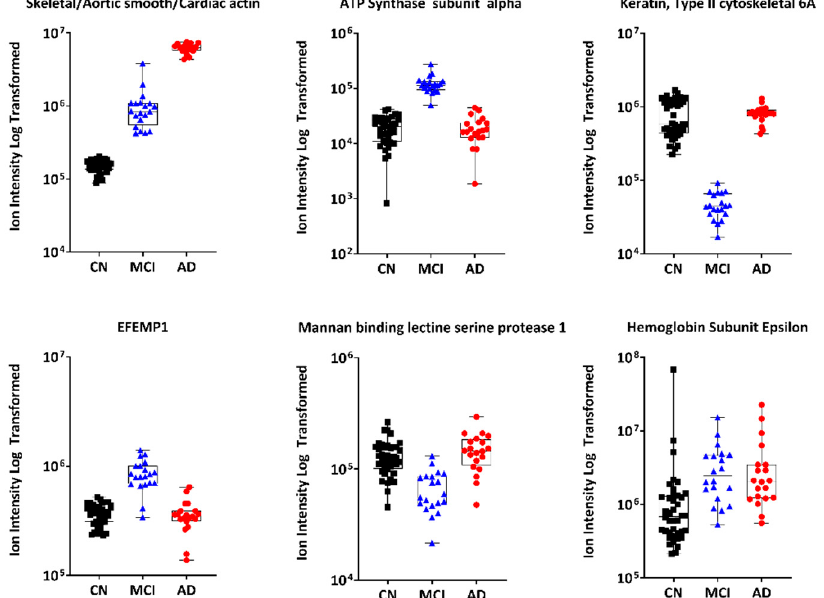
Figure 2. The top 6 protein biomarkers that separated the MCI group from the CN group in Table 2. The CN group is shown in black while the MCI and AD groups are shown in blue and red, respectively. Abbreviations: AD, Alzheimer’s disease; CN, cognitively normal; EFEMP1, epidermal growth factor containing fibulin like extracellular matrix protein 1; MCI, mild cognitive impairment.